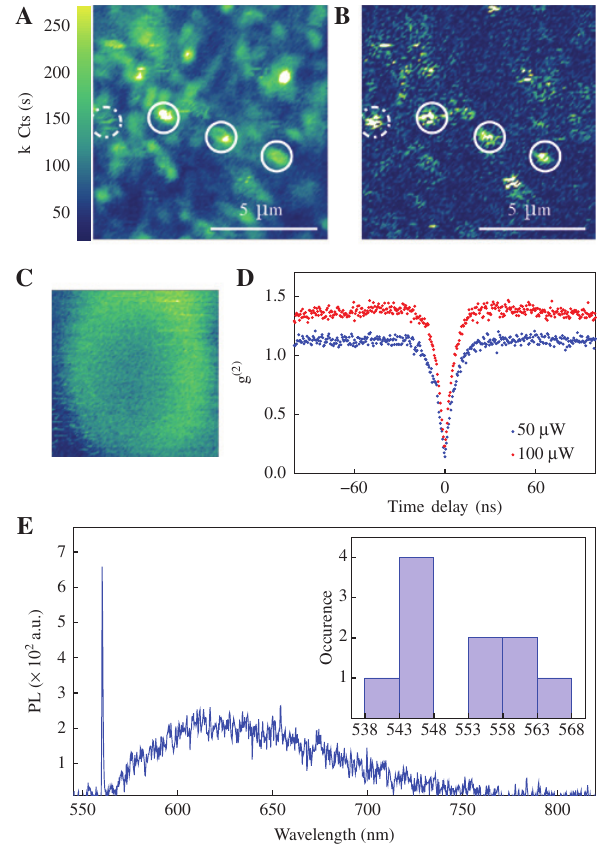
Figure 2: Optical characterization of the ST1 center. (A) A confocal fluorescence image of the natural diamond sample. The ST1 centers are identified by circles. A solid circle indicates that the center can be spatially isolated from other sources. (B) A confocal fluorescence image of the same region shown in Figure 2A with applied resonant microwaves. (C) Magnified image of a single site at high laser power, showing a doughnut-shaped fluorescence pattern. (D) Normalized photon autocorrelation function measured at different laser power showing anti-bunching at τ = 0. (E) The emission spectra of ST1 at 5 K with a prominent ZPL at 555 nm and PSB extending to 700 nm. The inset depicts a histogram showing the distribution in the position of the